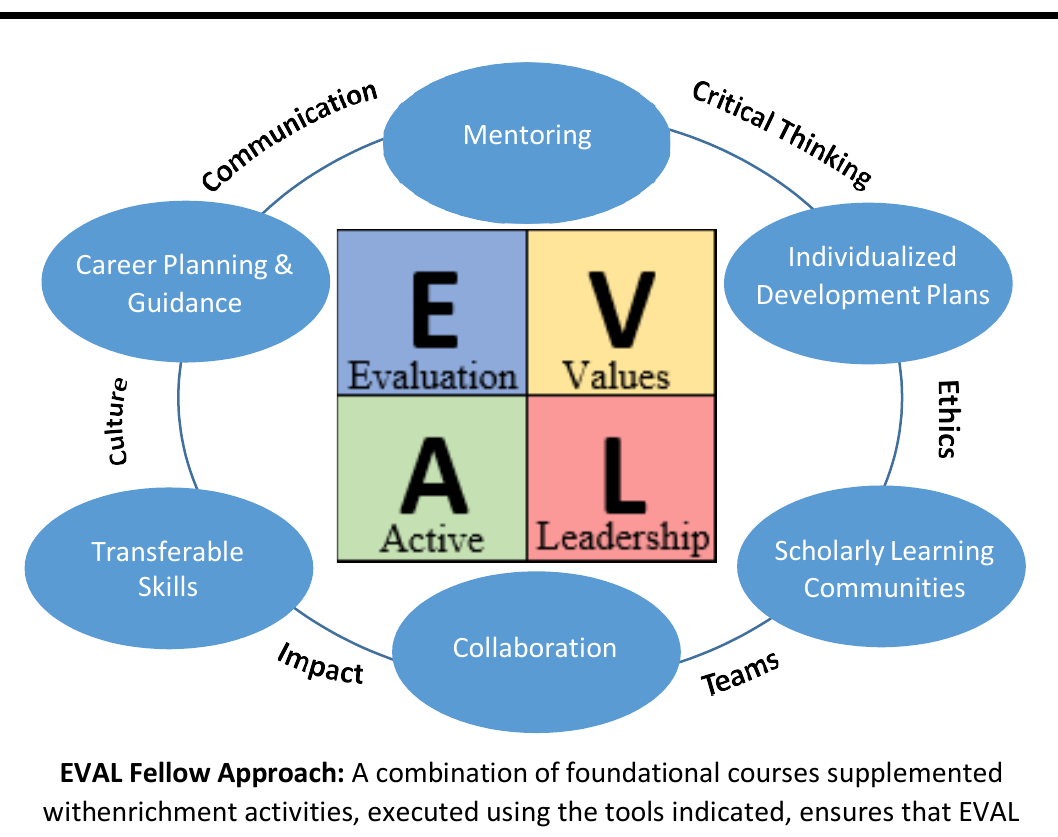
EVAL Framework: An Experiential